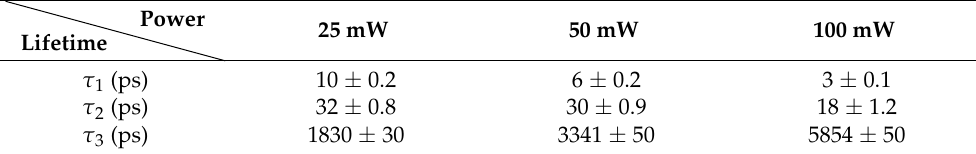
Table 1. Extracted lifetimes of different pump powers by the triexponential fitting. Power 25 mW 50 mW 100 mW Lifetime τ 1 (ps) 10 ± 0.2 6 ± 0.2 3 ± 0.1 τ 2 (ps) 32 ± 0.8 30 ± 0.9 18 ± 1.2 τ 3 (ps) 1830 ± 30 3341 ± 50 5854 ±